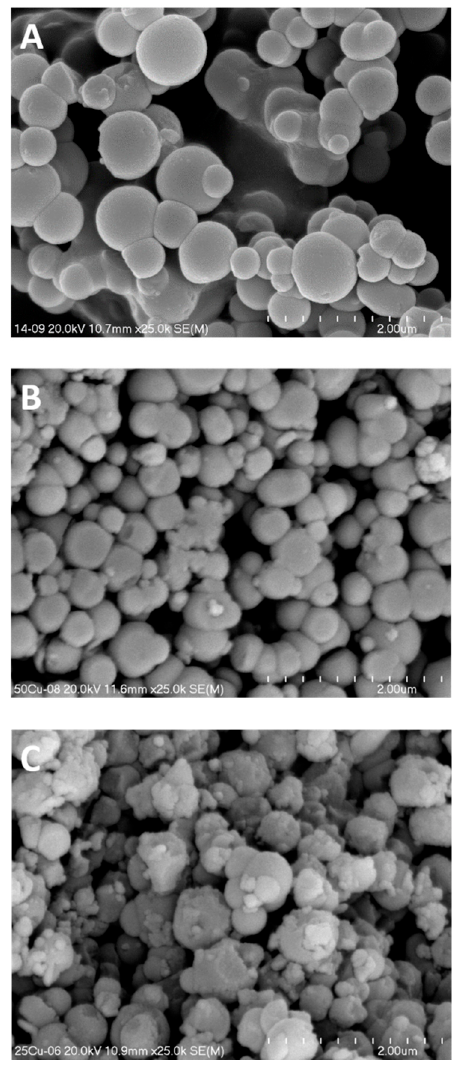
Figure 4. SEM micrographs of spherical Si-MCM-41 ( A ) and its modifications with copper—50Cu-MCM-41 ( B ) and 25Cu-MCM-41 ( C ).